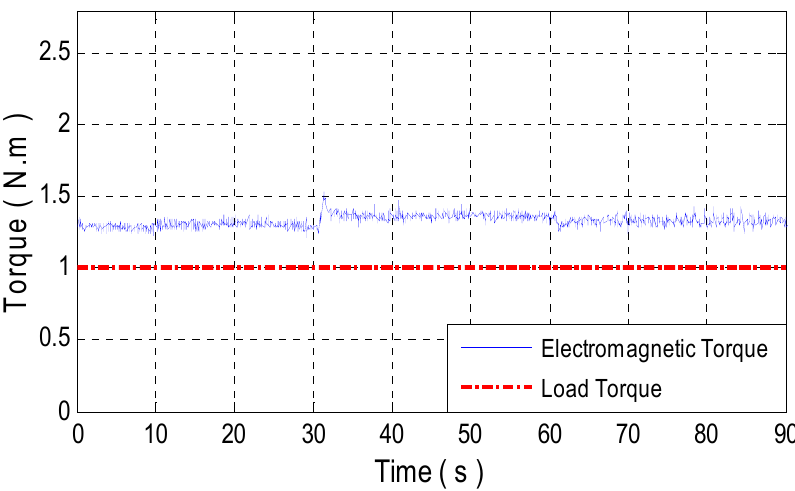
Figure 21. Load torque and electromagnetic torque.